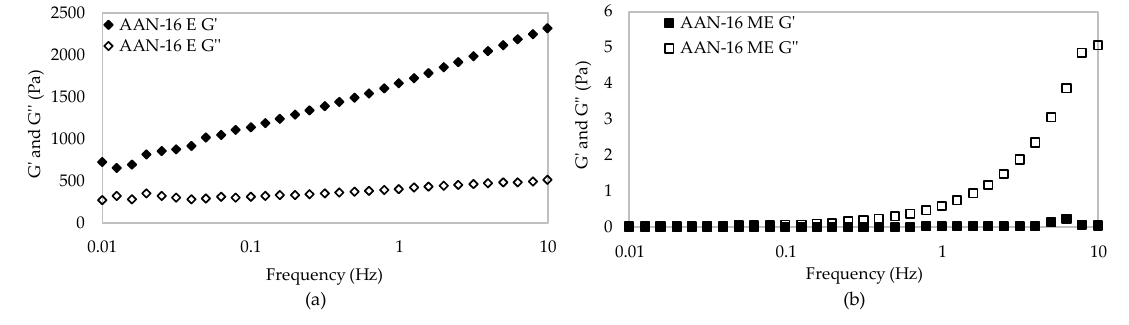
Figure 3. Oscillatory results of ( a ) AAN-16 E and ( b ) AAN-16 ME.